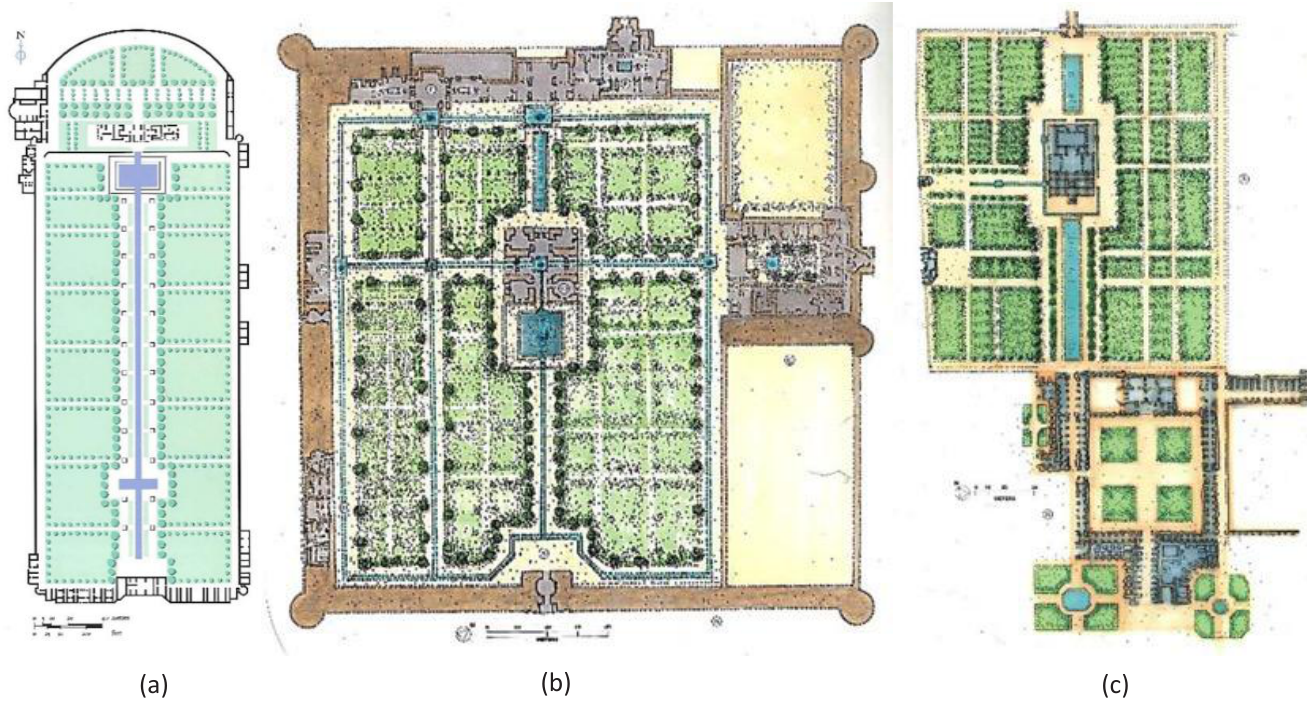
Figure 2. The geometrical structure of Persian garden Plan. (a) Shahzadeh-Mahan Garden. Kerman (Hobhouse 2003); (b) the Plan of Fin Garden, Kashan (Khansari et al. 1998); (c) the Plan of Chehel Sotun Garden, Esfahan (Khansari et al. 1998)